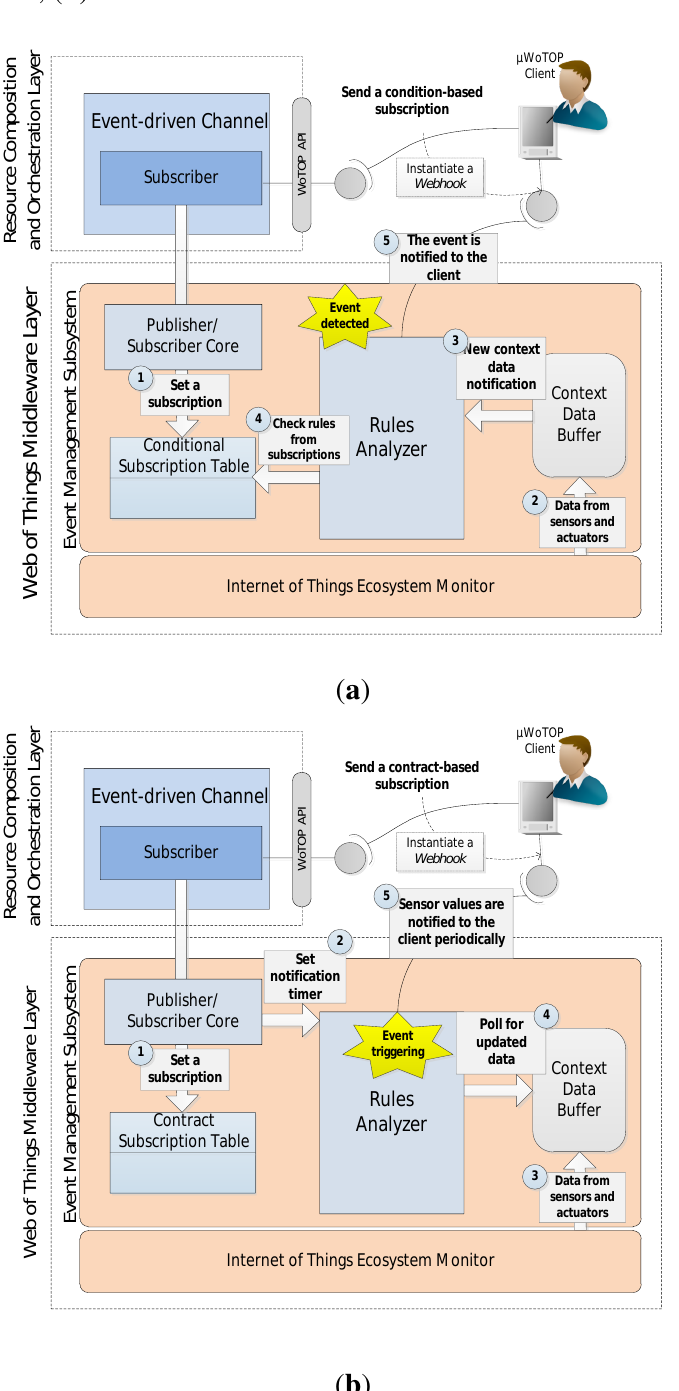
Figure 4. The two event-driven communication techniques supported by µ WoTOP: ( a ) condition-based; ( b )